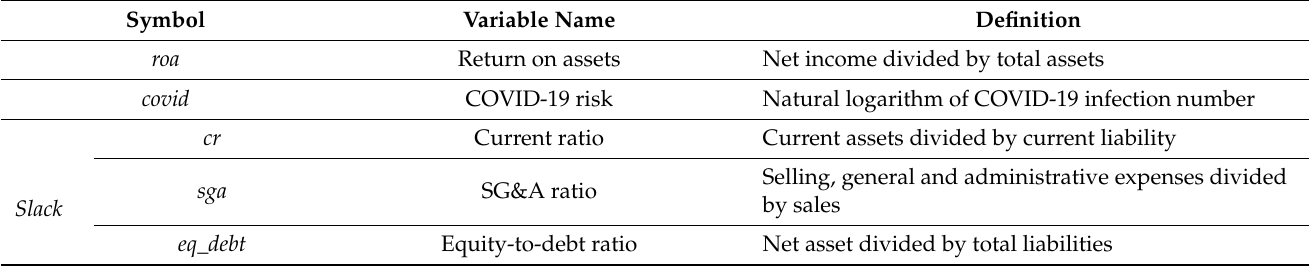
Table 2. Variable